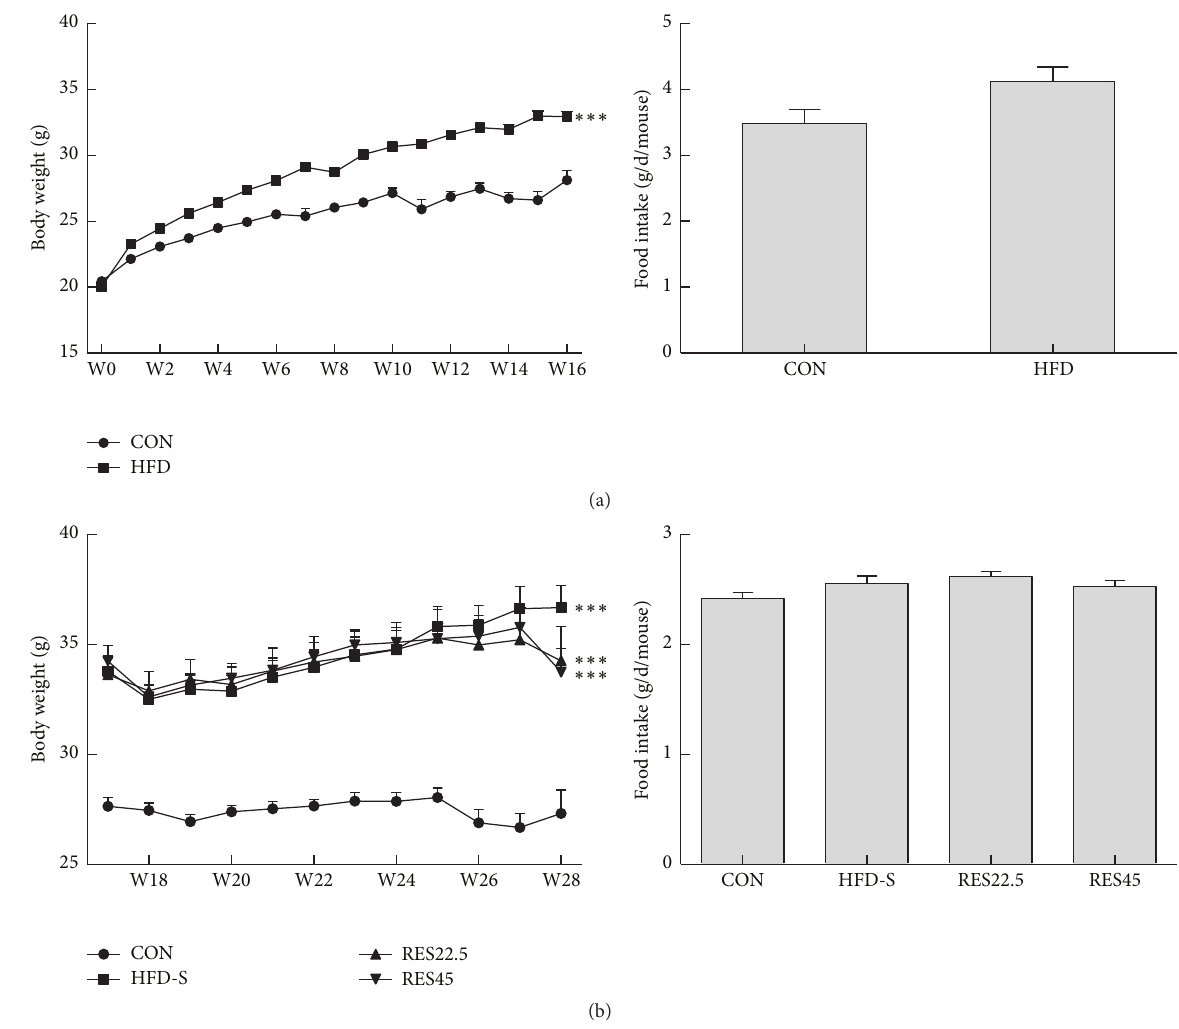
Figure 1: Body weight and food intake. (a) Body weight and food intake during 1–16 weeks in mice fed with HFD (CON, 𝑛 = 17 ; HFD, 𝑛 = 47 ). (b) Body weight and food intake during 17–28 weeks after resveratrol treatment in mice fed with HFD (CON, HFD-S, RES22.5, and RES45, 𝑛 = 15 ). One-way ANOVA was used to test for statistical significance. Data were expressed as the mean ± SEM. ∗∗∗ 𝑃 < 0.001 versus the CON